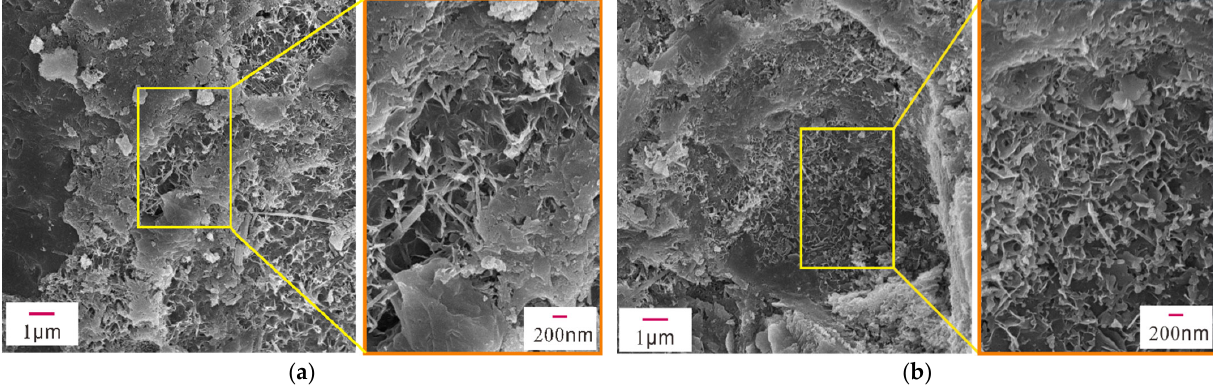
Figure 6. SEM images of sample 3N. ( a ) Partial SEM image of sample 3N, ( b ) Partial SEM image of sample 3N.